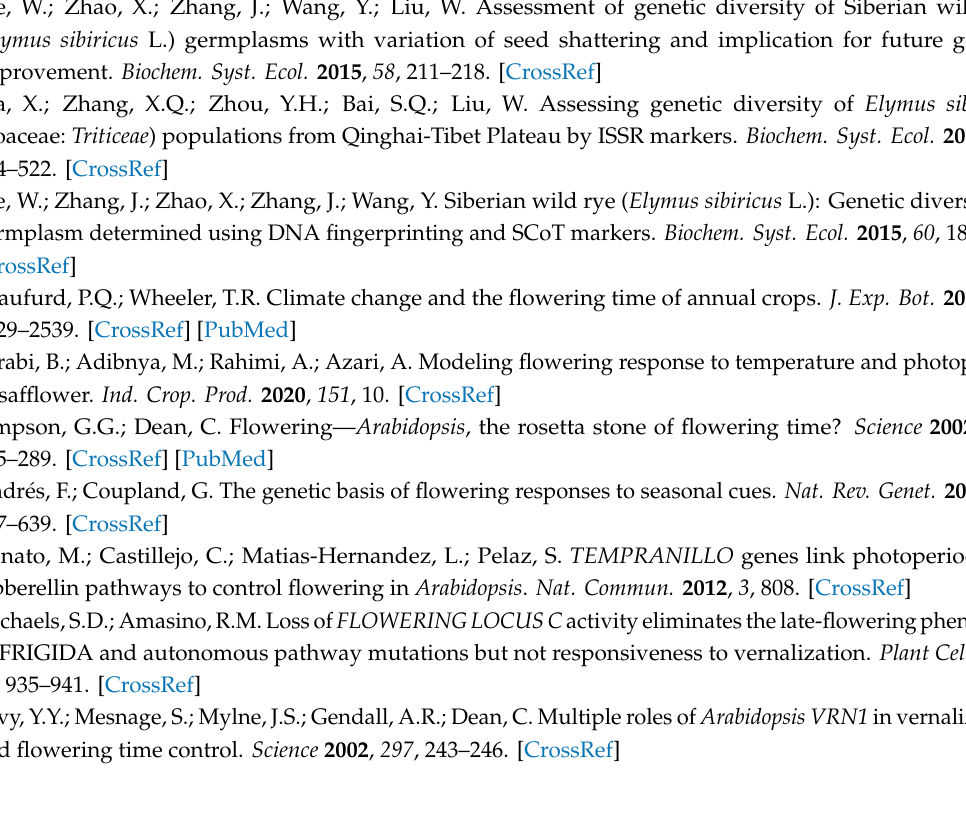
Table S1: Summary of the sequence data analysis. Table S2: Statistics of Unigene Library of E. sibiricus. Table S3: BLAST analysis of the non-redundant unigenes against public databases. Table S4: The unigene sequence of 155 candidate genes. Table S5: Information of flowering candidate genes and gene-based EST-SSRs primers: reverse and forward sequence, Tm, molecular weight of expected band. Table S6: The coe ffi cient of genetic similarity of 20 E. sibiricus